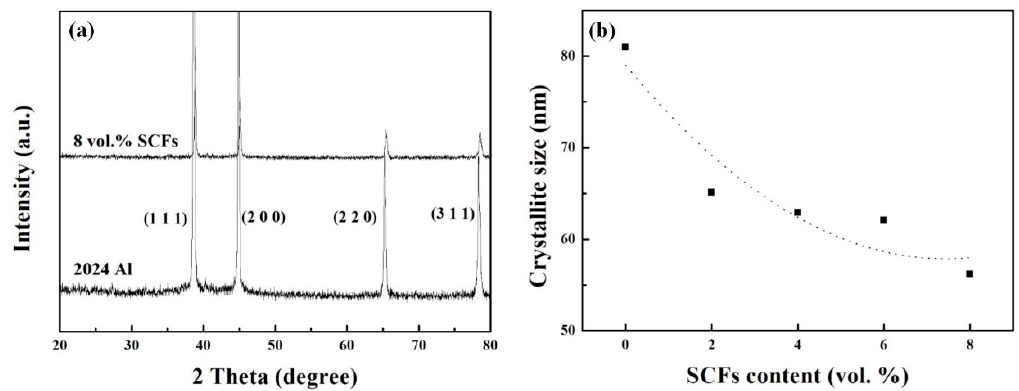
Figure 3. ( a ) XRD patterns for 2024 Al and 8 vol. % SCFs/2024 Al composites, ( b ) the relationship between crystallite size of the aluminum matrix and SCFs content.